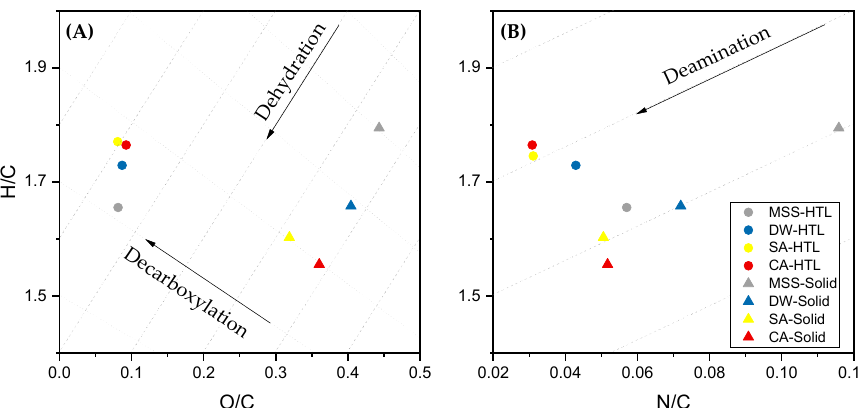
Figure 6. Van Krevelen diagram of MSS, solids from pre-treatment, and HTL derived biocrude, plotted as ( A ) O/C vs. H/C ratio and ( B ) N/C vs. H/C ratio.